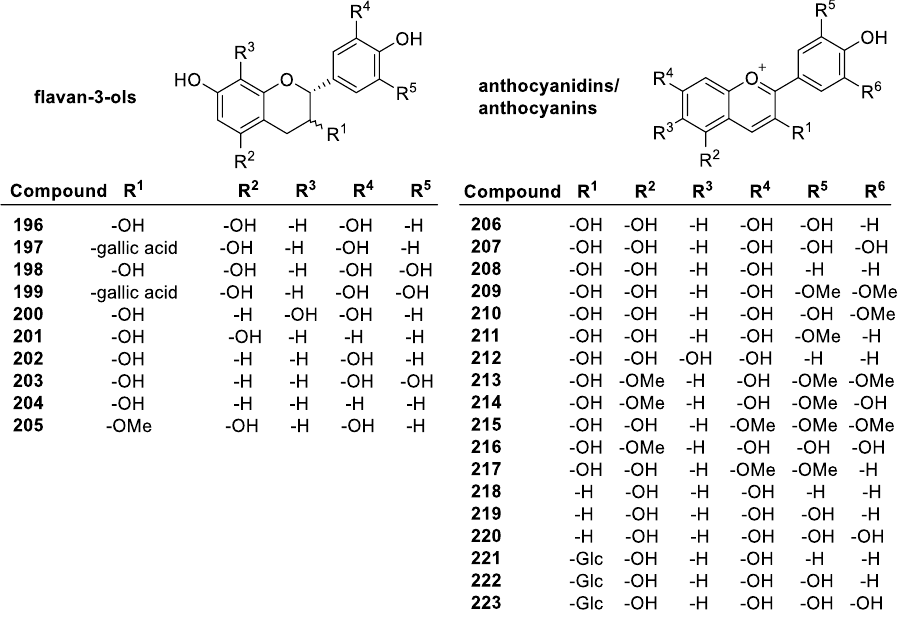
Figure 13. Representative examples of flavan-3-ols and anthocyanidins/anthocyanins with antiox- idant effect.